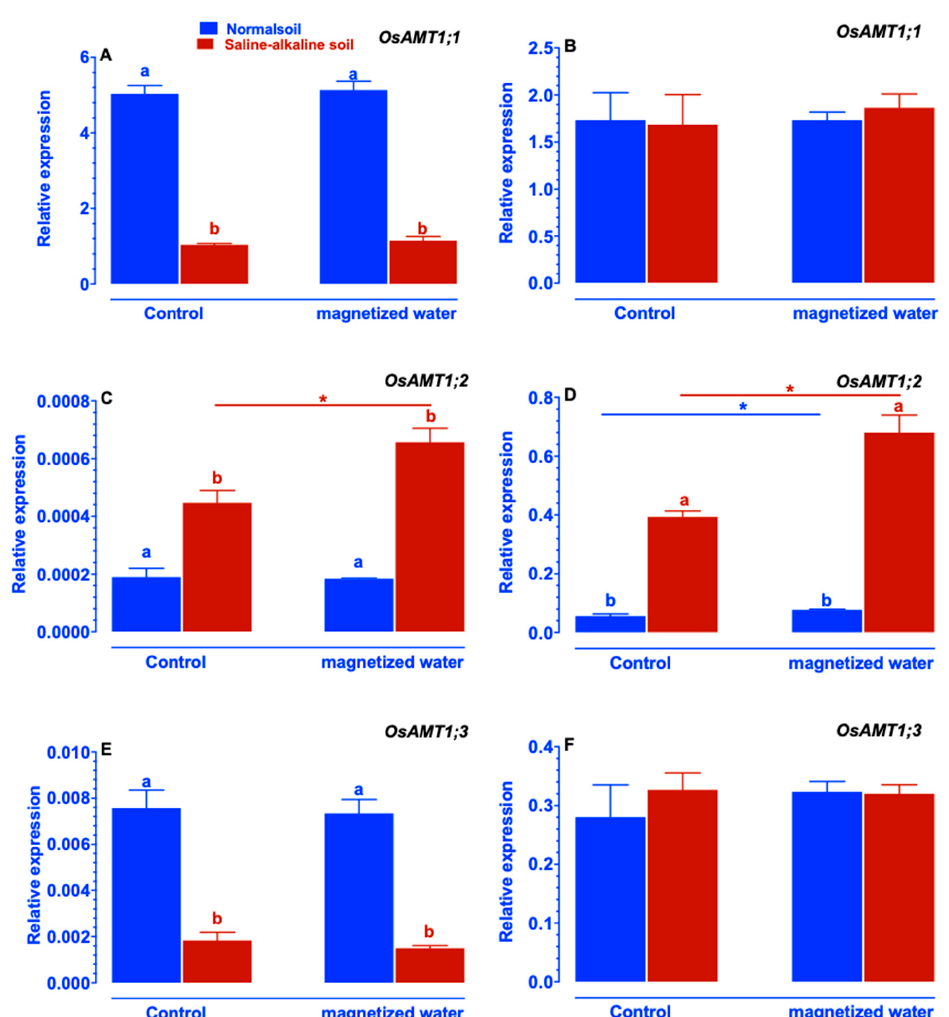
Figure 6. Effects of magnetized water on the expression of the OsAMT1 gene family in Nipponbare seedlings grown in normal and saline–alkaline stress soil: ( A ) OsAMT1;1 in shoot, ( B ) OsAMT1;1 in root, ( C ) OsAMT1;2 in shoot, ( D ) OsAMT1;2 in root, ( E ) OsAMT1;3 in shoot, ( F ) OsAMT1;3 in root. Treatments were as described in Figure 1. Means with different letters are significantly different ( p < 0.05) within the same treatment. Asterisks indicate significant differences between control and saline–alkaline stress of the same genotype, as determined by Student’s t -test (* p < 0.05). Expression levels of OsAMT2;1 and OsAMT2;2 in shoots of Nipponbare plants grow- ing in saline–alkaline stress soil were markedly upregulated by exposure to magnetized water (Figure 7A,C), while the expression levels of OsAMT2;3 in shoots of Nipponbare plants were unaffected by exposure to magnetized water (Figure 7E). The expression of OsAMT2;1 , OsAMT2;2 , and OsAMT2;3 in the roots of Nipponbare plants growing in both normal and saline–alkaline stress soil was increased by irrigation with magnetized water (Figure